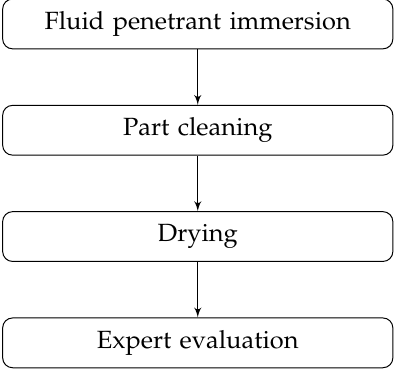
Figure 1. FPI general